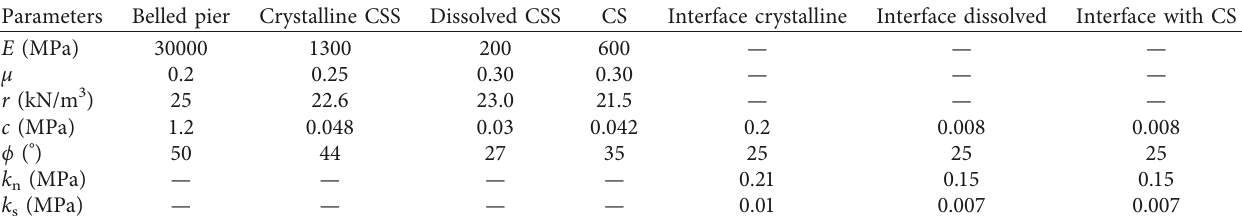
Table 1: Model parameters in computation.